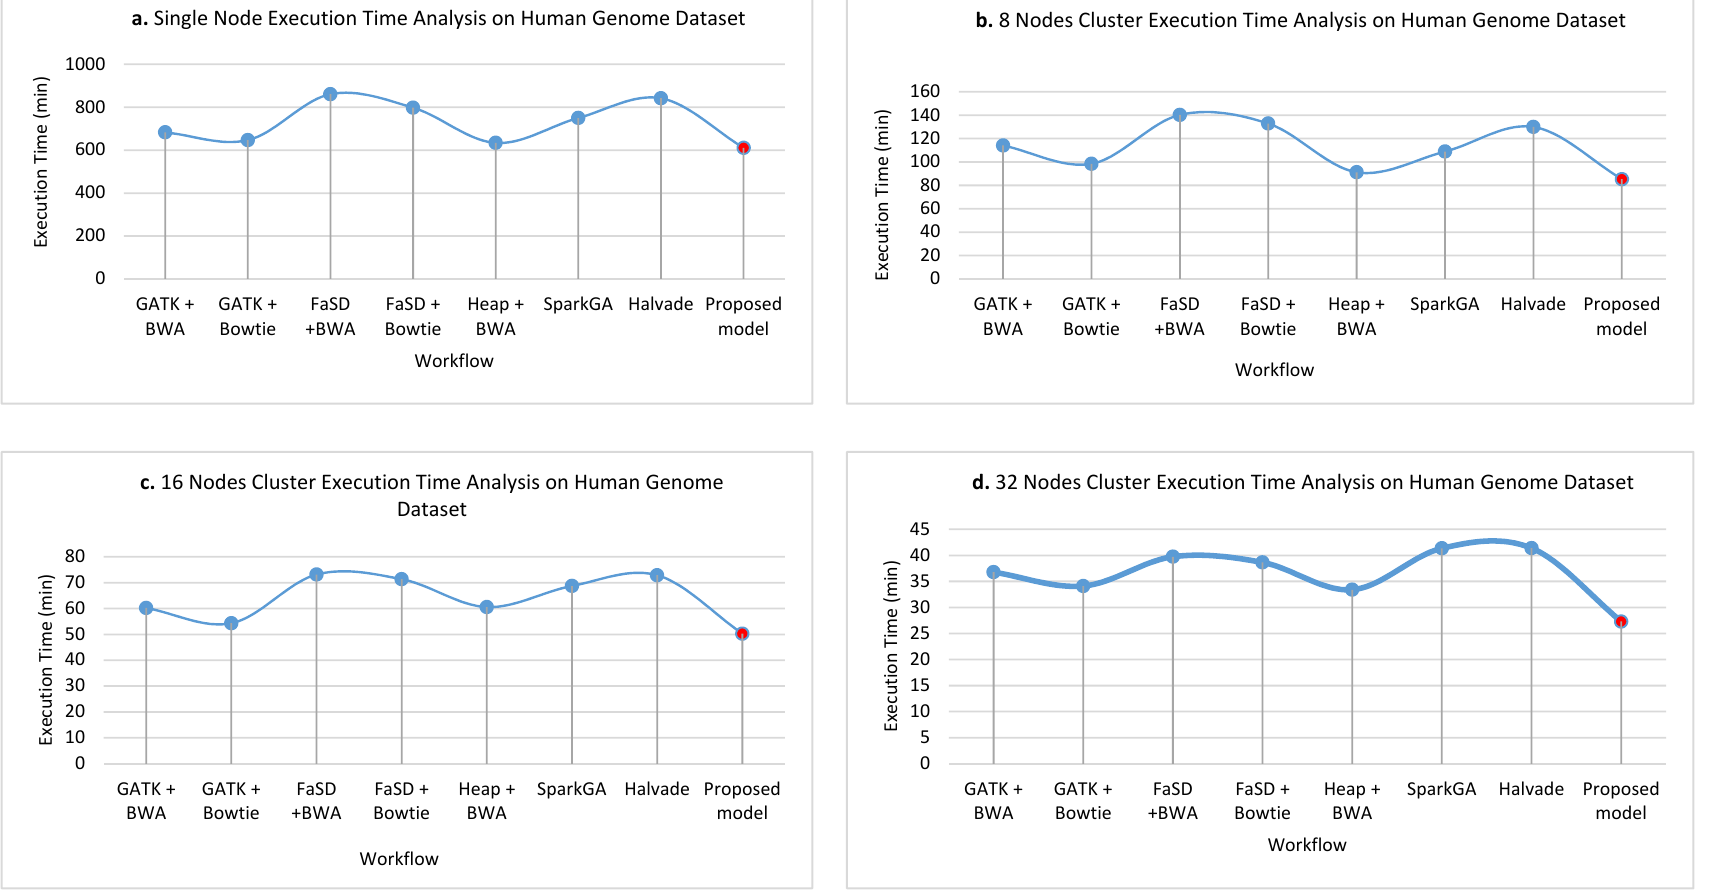
Figure 6. The execution time of single node pseudo cluster, 8 nodes, 16 nodes and 32 nodes real clusters are shown in part ( a – d ) respectively for the human genome dataset. The light blue filled circles over the line show the points for existing workflows and the solid red filled circle shows the values for the proposed workflow. Its analysis shows that the proposed model takes less time in execution while detecting SNPs in the human genome dataset.